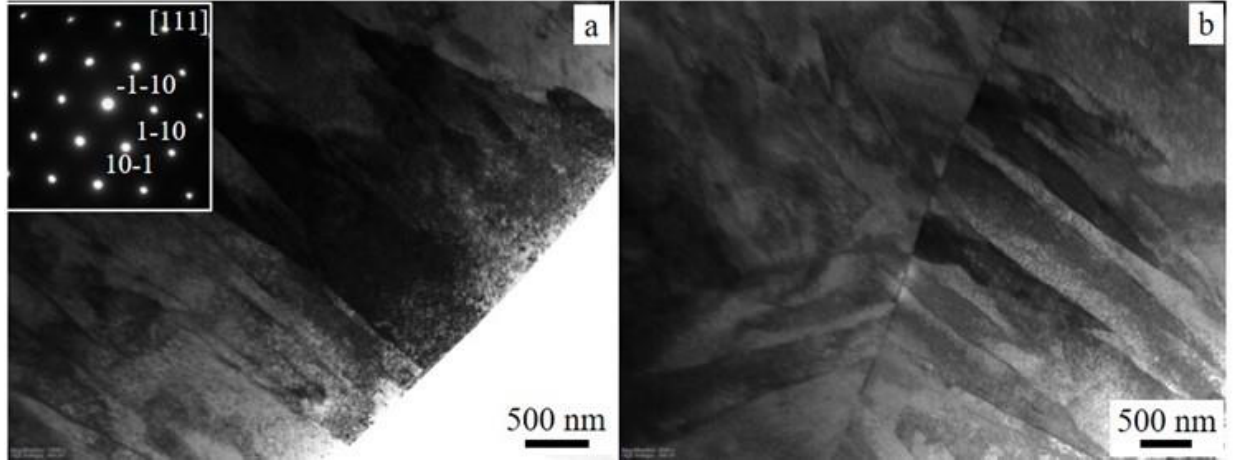
Figure 5. TEM bright-field images of the as-printed 17-4 ss ( a , b ). The insert in ( a ) is a selected area diffraction pattern recorded along the [111] zone axis from the image. The image in ( b ) shows the grain boundary and lath structures.